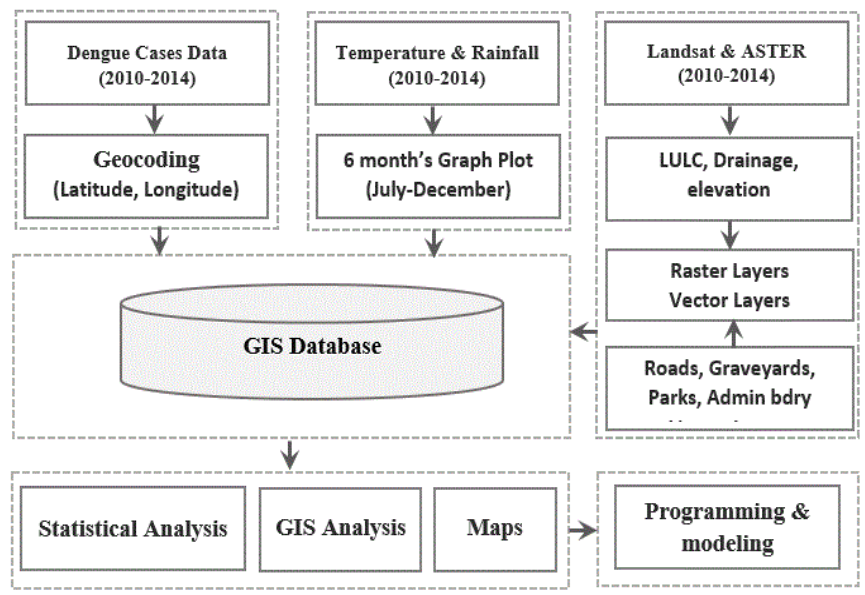
Figure 2. Flow diagram of data collection, pre-processing, processing and analysis.